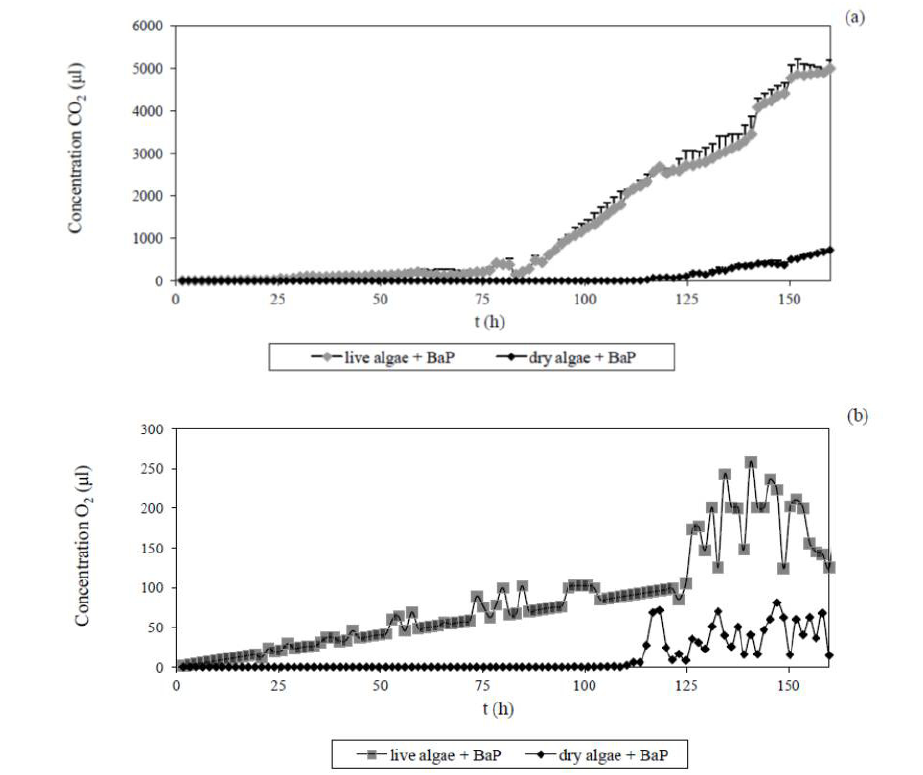
Figure 2. Cumulative production of CO